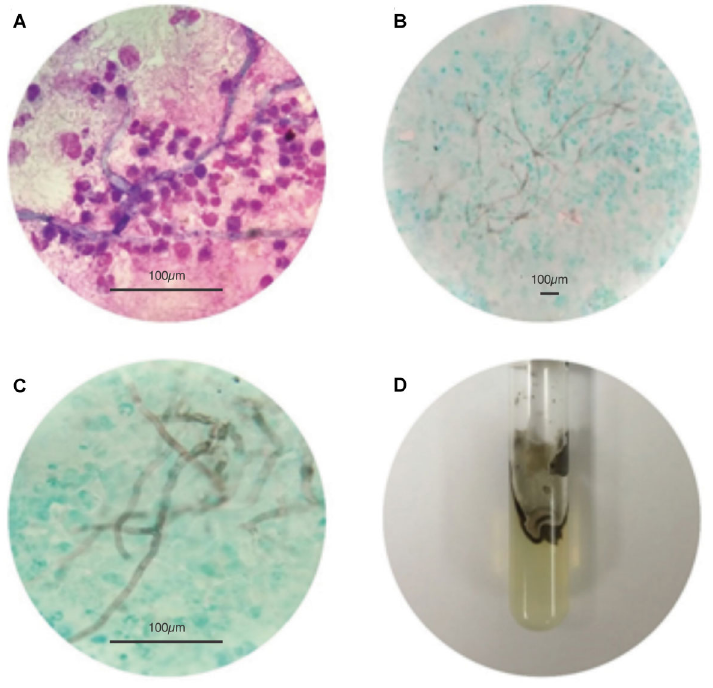
Figure 4. Presence of brown septate hyphae in the cytological examination of the cystic content with Leishman staining (600 (cid:1) ) ( A ) and Fontana-Masson staining, 100 (cid:1) ( B ) and 600 (cid:1) ( C ), respectively. Scale bars: 100 m m. D , Aspect of fungal growth in Sabouraud agar